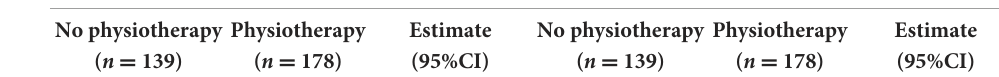
TABLE 4 Outcomes in patients hospitalized with COVID-19 before and after overlap propensity score-weighting.